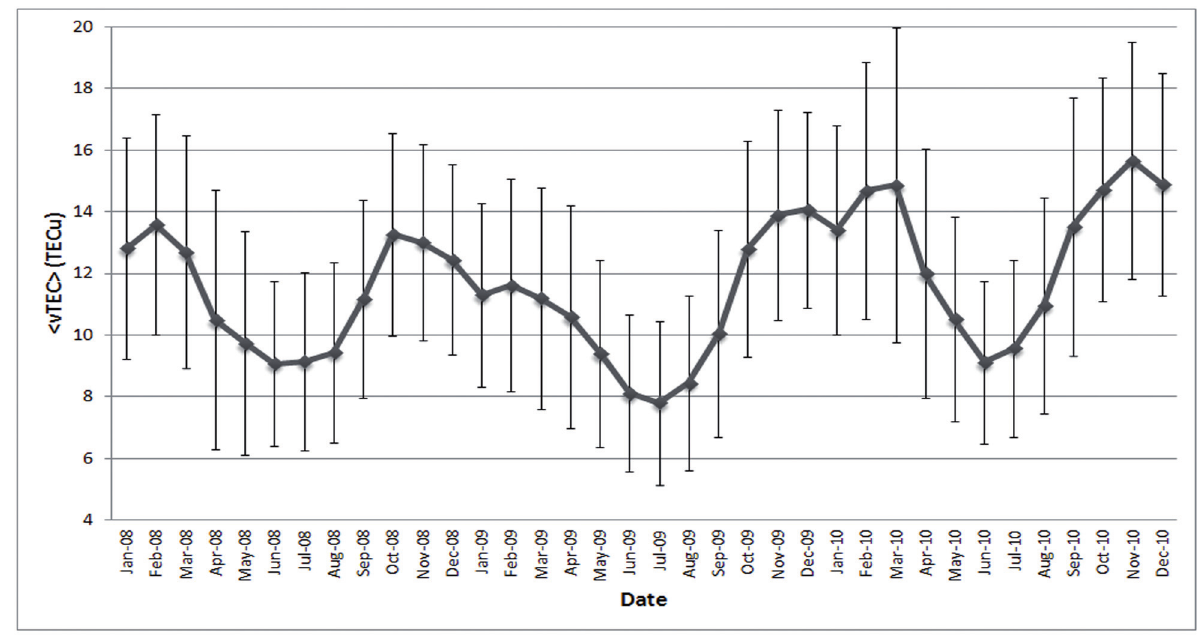
Figure 8. Mean monthly variation of the vTEC over the whole field of view of the ISACCO-DMC0 station for the three years considered. The error bars show the SD of the